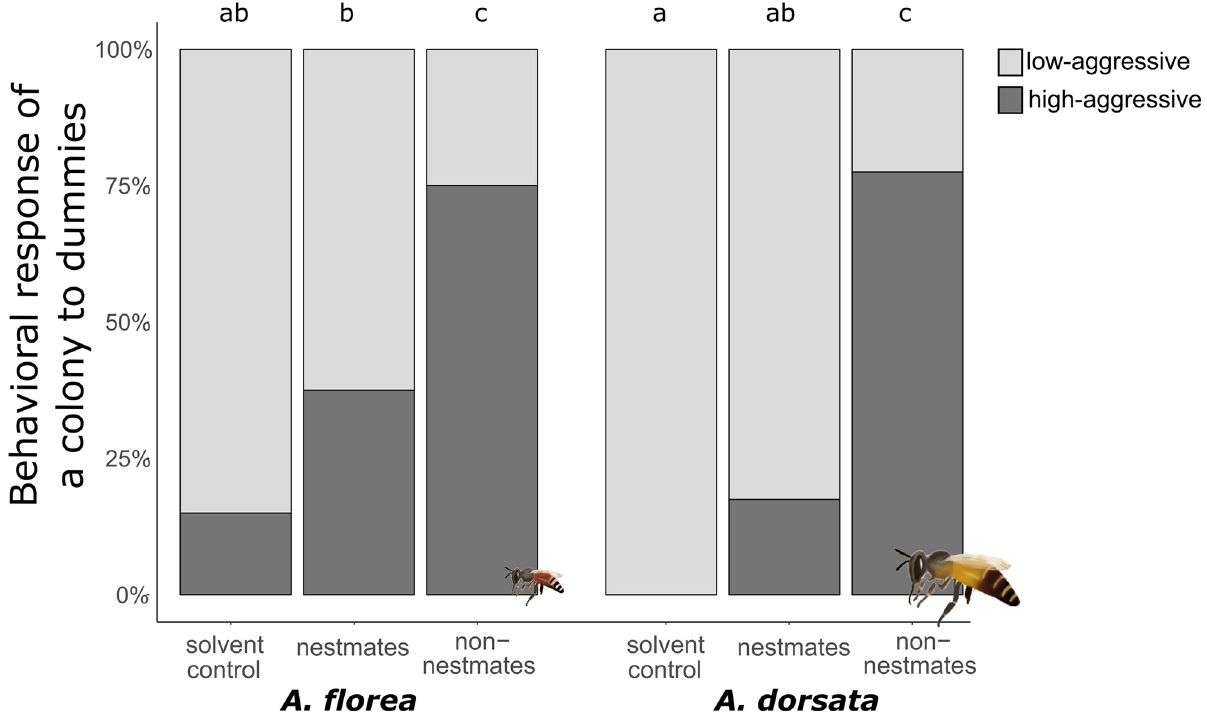
Fig 5. The behavioral response of a colony to odor dummy. The behavioral response of a colony (high-aggressive: dark grey: low-aggressive: light grey) to odor dummies is shown. Dummies applied with solvent served as control. Letters are indicating significant differences in the proportion of high-level aggressive and low-level aggressive colony responses achieved via post-hoc Tukey test. For all tests related to species x dummy type, 40 individual dummies were tested.